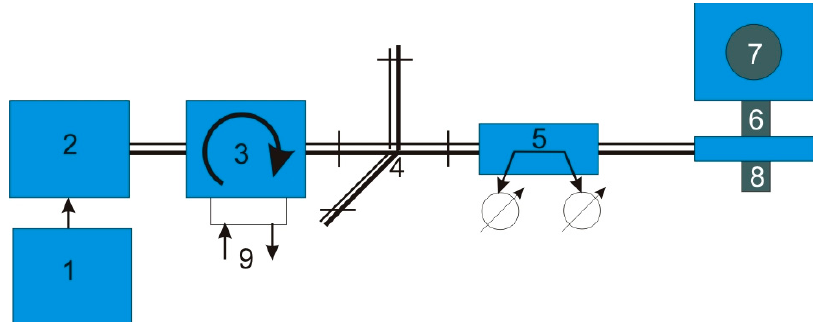
Figure 3. Block diagram of a test line where: 1—power supply; 2—generator; 3—circulator; 4—matching circuit, 5—reflectometer; 6—coaxial plasma head; 7—reaction chamber; 8—gas inlets; 9—cooling water.